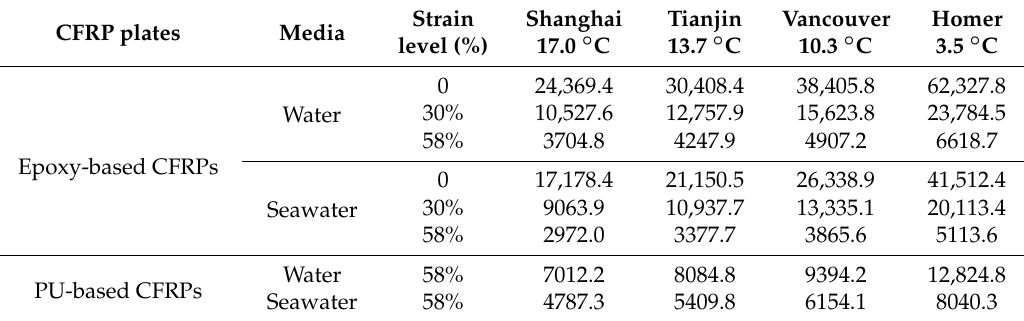
Table 7. τ ( R 2 ≥ 0.98) of regression equation in Equation (21) for the life prediction curves.